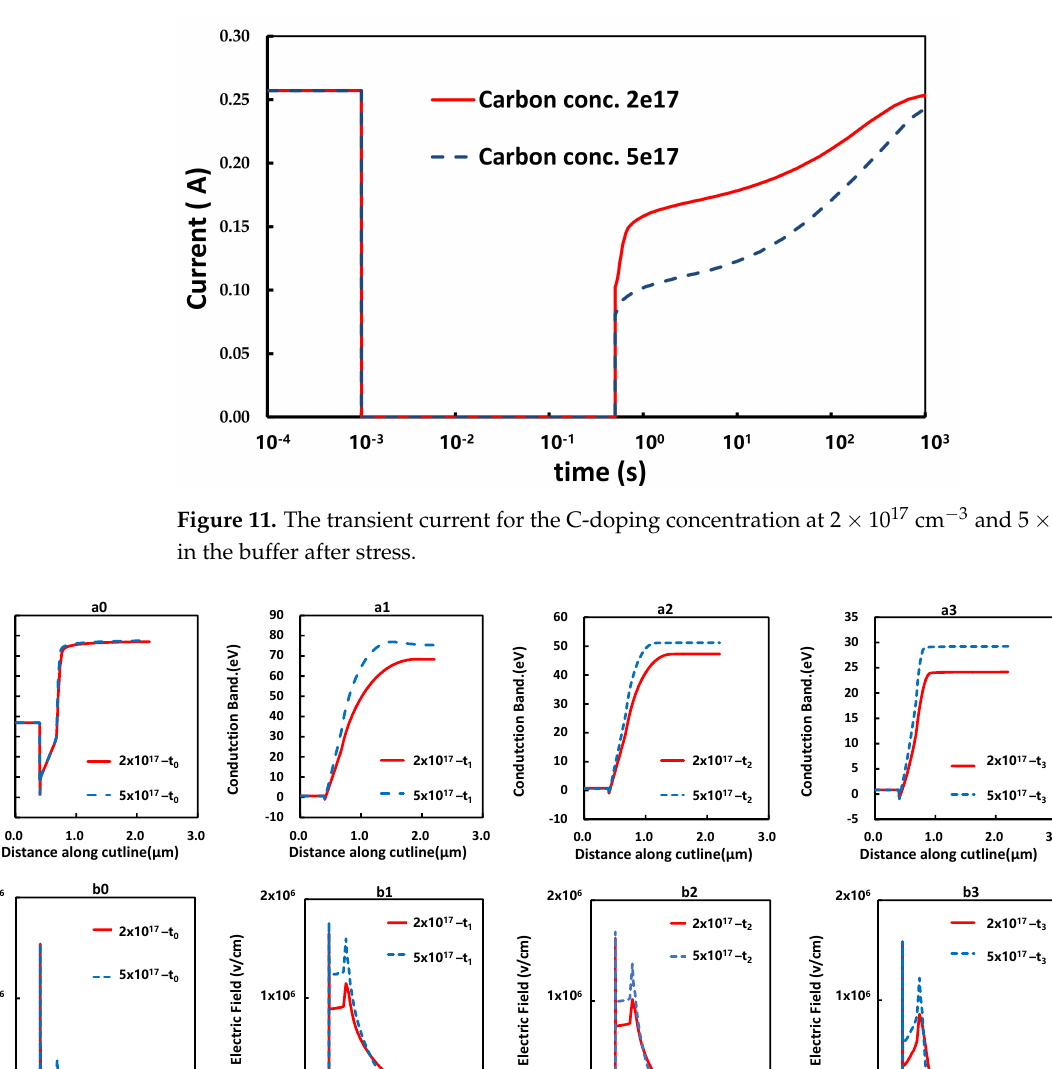
Figure 12. ( a 0 – a 3 ). The curve of the conduction band of the device with different carbon doping concentrations at different moment t 0 ~t 3 ; ( b 0 – b 3 ). The electric field of the device with different carbon doping concentrations at moments t 0 ~t 3